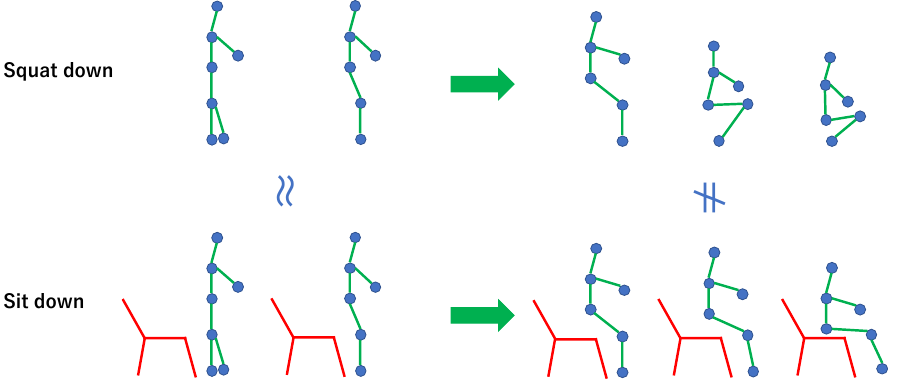
Figure 1. Example of motions that show that starting motions are very similar, but the future motions are different. In such cases, the predictions may be difficult, or the deep learning model may not train well. It is not enough to use only the 3D human skeleton sequence of starting